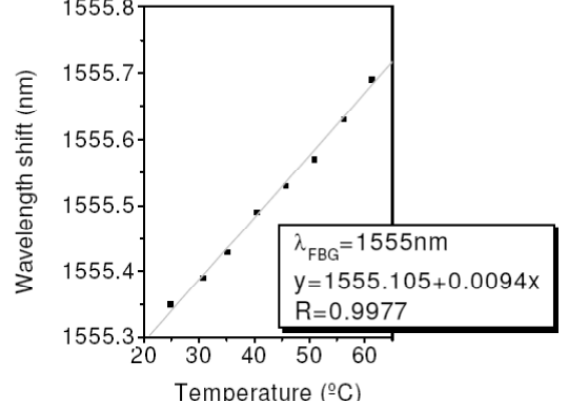
Figure 8. Shift wavelength of the heated up